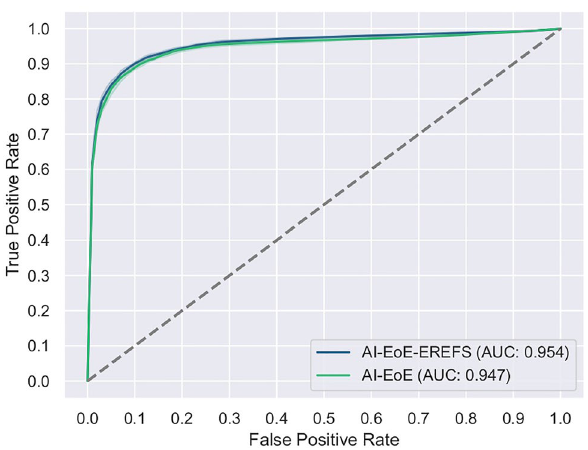
Figure 3. ROC curves and AUC values of AI-EoE and AI-EREFS on the internal data set